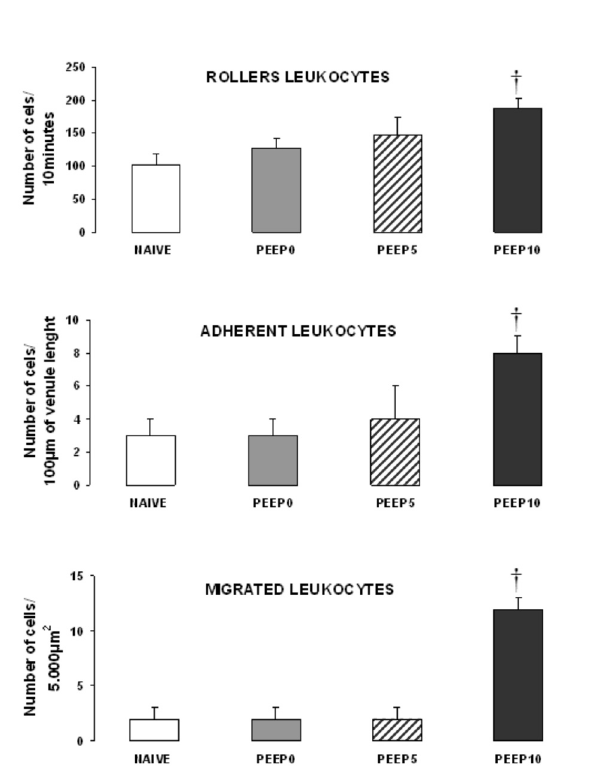
Figure 3 - Rolling (number of cells/10 minutes), adherent (number of cells/100 µm venule length) and migrated leukocytes (number of cells/5,000 µm 2 ) in post-capillary venules at the mesentery (mean values ± SD) in NAIVE (n=3), PEEP0 (n=6), PEEP5 (n=6) and PEEP10 (n=7) groups. †, p<0.01 PEEP10 vs. other groups